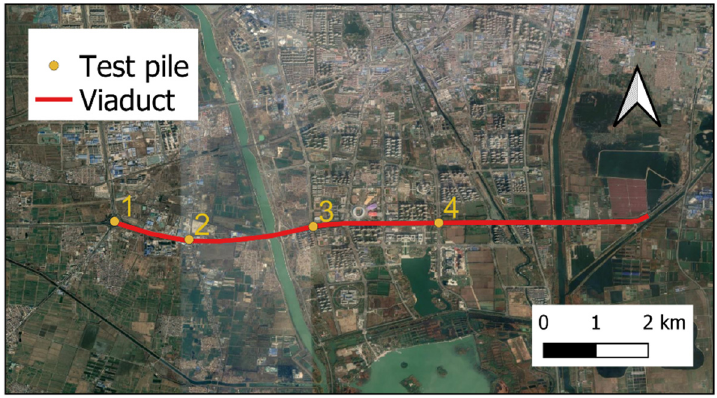
Figure 1. Test pile location (in scale).